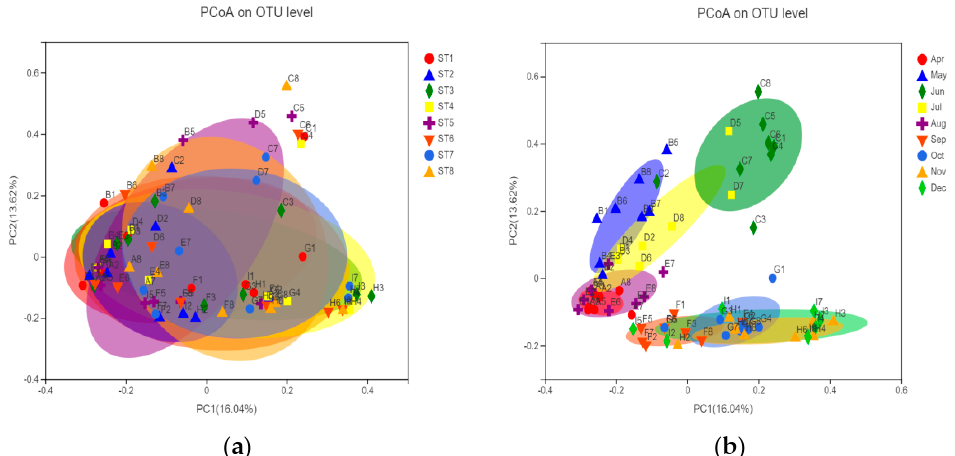
Figure 5. PCoA analysis of community composition (spatial groups ( a ) and temporal groups ( b )). Points of different colors or shapes represent samples of different groups. The closer the two sample points are, the more similar the species composition is.